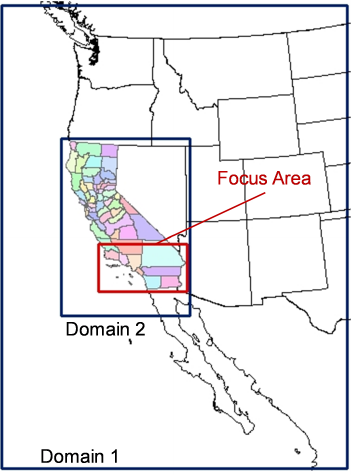
Figure 1. Simulation domains in this study. The red rectangle de- notes the area of southern California where most analyses in this study are